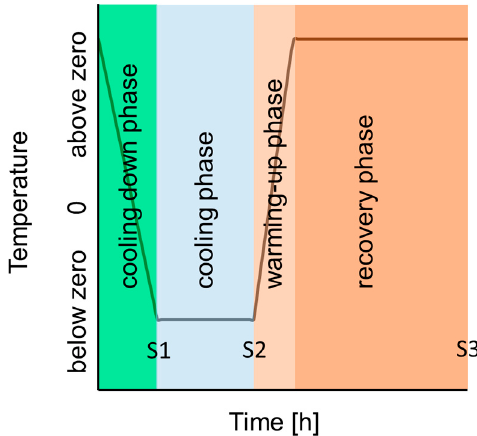
Figure 8. Scheme of the temperature profile during step cooling. S1, S2, and S3 mark the sampling times.